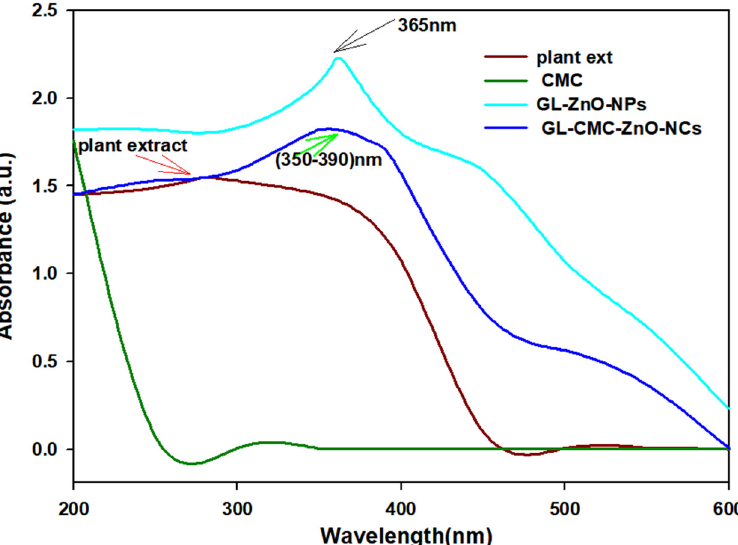
Figure 2. UV ̶ VIS absorbance spectra of hydroponic ginseng leaves ZnO NCs with the CMC polymer. The brown line indicates the result for the plant extracts; the green line indicates the result for the CMC; the violet line indicates the result for the GL–CMC–ZnO NCs; the blue line indicates the result for the GL–ZnO nanoparticles (NPs).